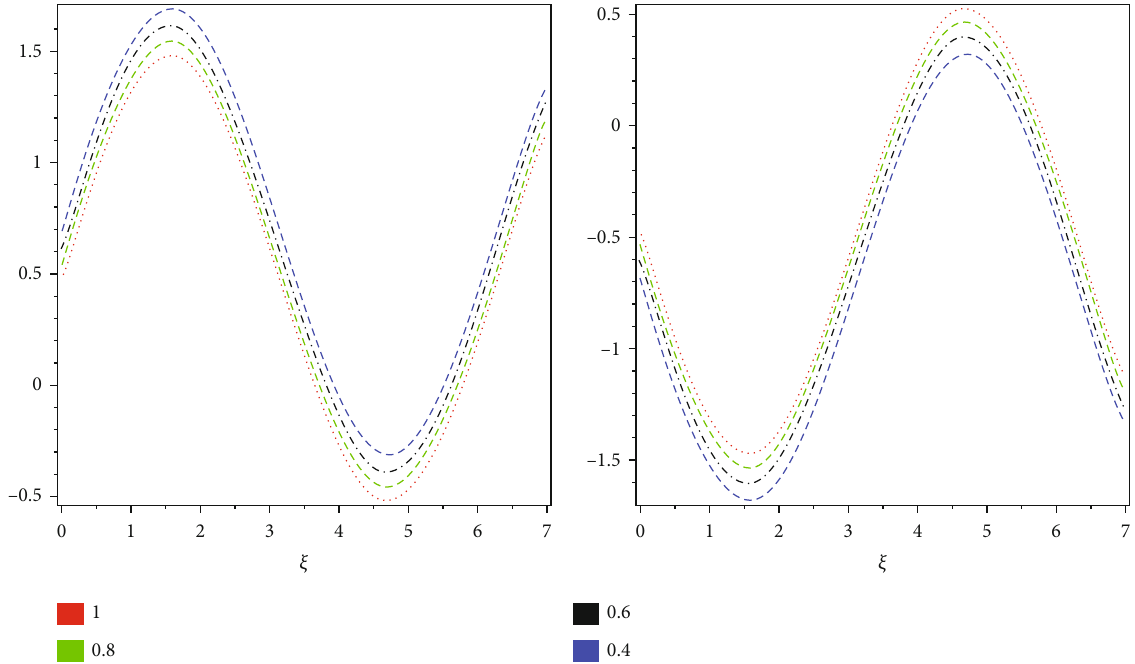
Figure 4: First two-dimensional fuzzy upper branch graph and second bottom branch graph of an analytic series result of various fractional of ρ